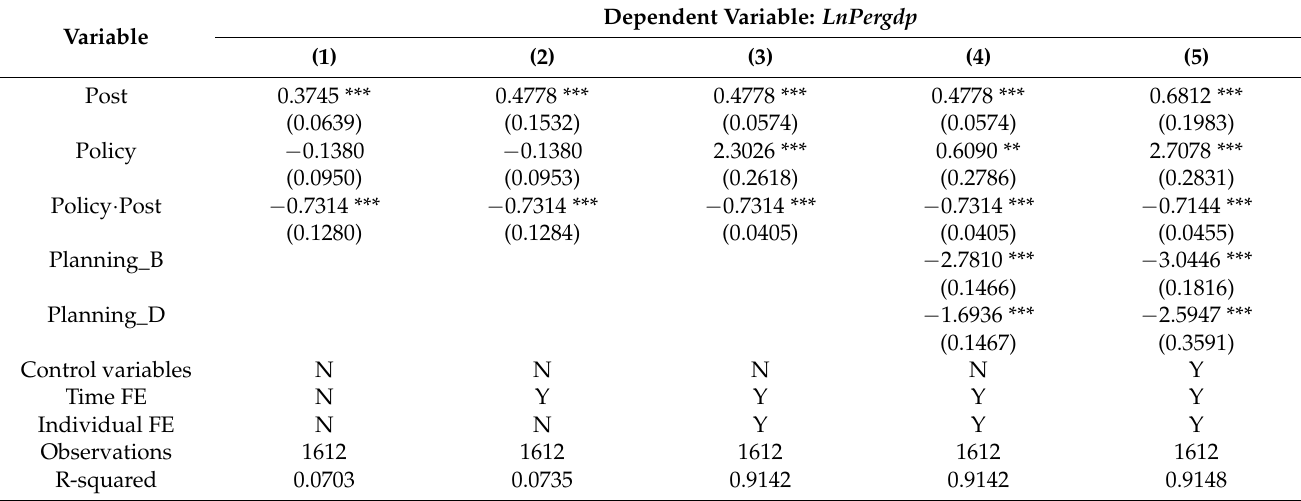
Table 3. Benchmark regression